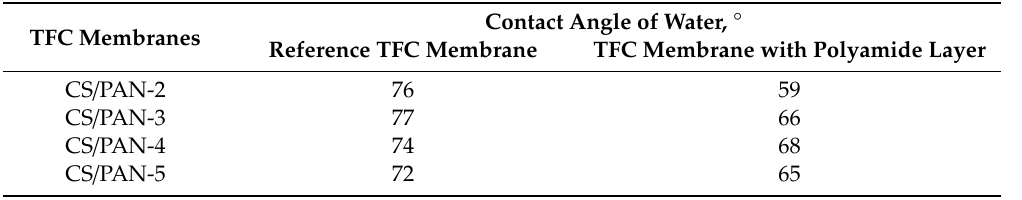
Table 3. PAN membrane performance in ultrafiltration of PVP K-30 and BSA solutions and total membrane porosity. The mean accuracy for contact angle was ± 2 ◦